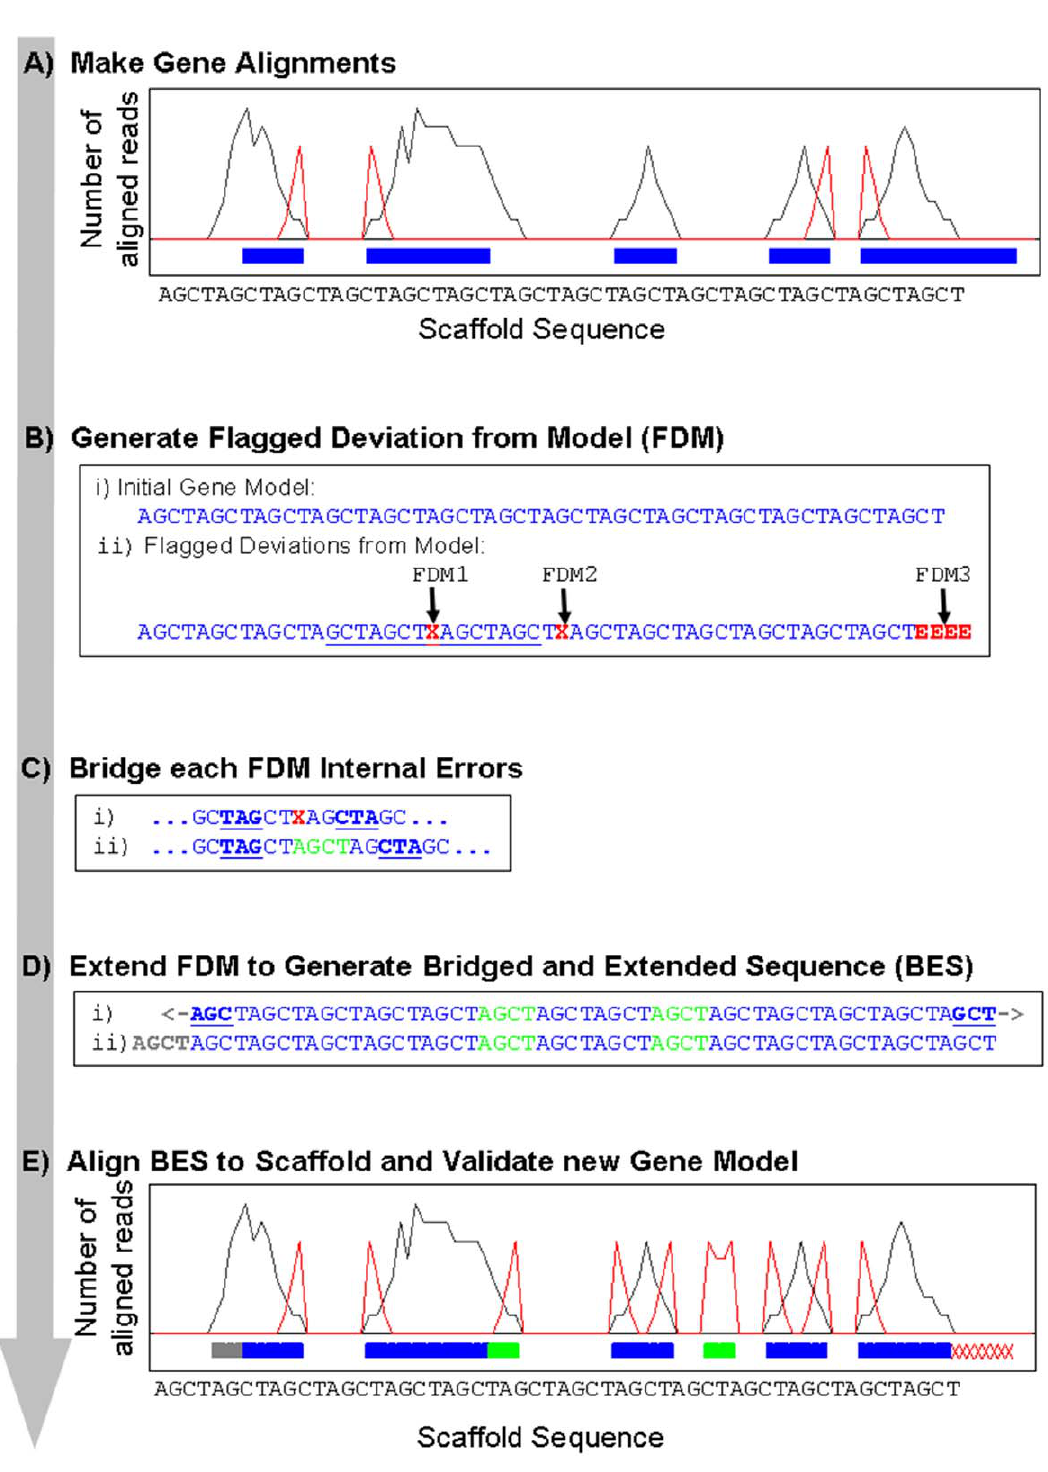
Figure 1. Overview of the structural annotation analysis method. In the illustrations, the original gene model is shown in blue, the number of aligned reads at a particular bp in the scaffold is in grey, and the number of reads that align to the gene model but not to the scaffold are in red. A) Bowtie is used to align RNA-seq reads and identify regions where expressed RNA sequence does not match predicted gene model. B) Errors in the gene model are identified where there is a predicted intron (i=predicted expressed gene sequence) but no spanning expressed sequence (‘‘1’’ and ‘‘2’’ in example above) or where there is predicted gene but no sequence alignments (‘‘3’’ in above example). The resulting flagged deviation from the model (FDM) is tagged with ‘X’ to indicate the presence of an internal error in the gene model or and an ‘E’ to indicate an error at the beginning or end of the gene model as illustrated by the expressed sequence string in Dii. C) For each internal error (red X) in FDM, such as error ‘‘1’’ in (A), an 18- mer ‘probe’ sequence is generated up and downstream of error (underlined and bold sequence in (Ci). This intron-spanning sequence was used to search the set of RNA-seq reads. for contiguous expressed sequence between selected probes (Green sequence in (Cii).) D) Error from beginning and end of FDM (such as Error ‘‘3’’ in above example) are removed by probes sequences generated from beginning and ends of expressed gene sequence